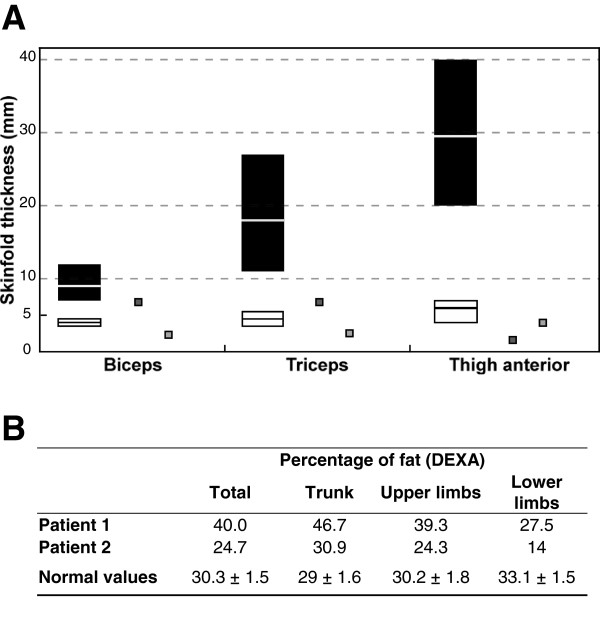
Body fat distribution of patients: Skinfold thickness and whole-body dual-energy X-ray absorptiometry (DEXA). (A) Skinfold thickness measured in patient 1 (dark grey squares) and patient 2 (light grey squares) as compared to that reported in typical FPLD2 women with LMNA p.R482 heterozygous substitutions (white rectangles) and control women (black rectangles) [29,30]. Median and range values are indicated. (B) Results of DEXA in patients 1 and 2, showing that body fat was predominantly distributed in the trunk area. Normal values (mean ± SD) are from [31].